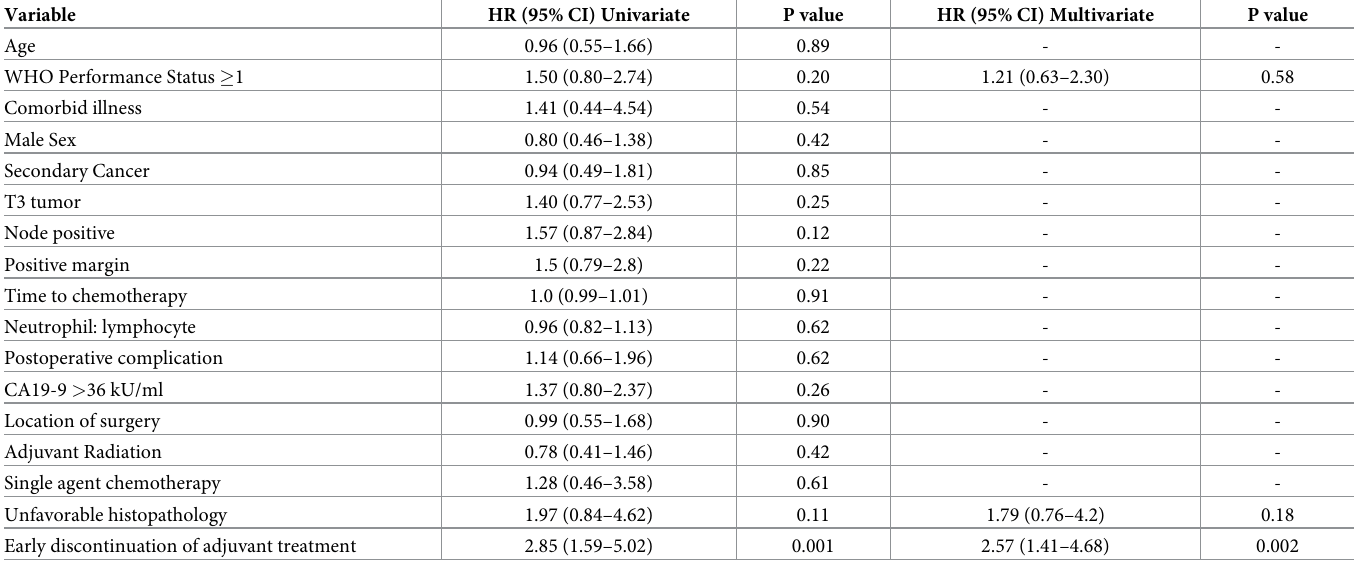
Table 4. Cox proportional analysis and modelling of various clinical and pathological variables that correlate with recurrence of the disease (Recurrence-free survival). Variable